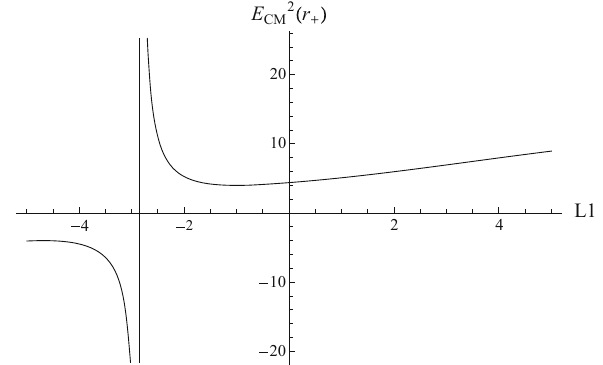
Fig. 3 The behavior of the CM energy E 2 function of L 1 with ν = 2 . 5, E 1 = E 2 = 1, L 2 = − 1 r − = 1, r + = 2 and l = 1